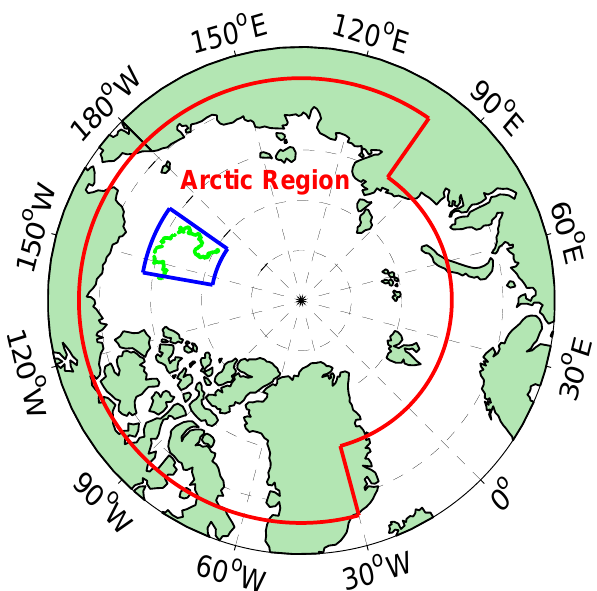
Fig. 1. Arctic Ocean as defined in this study. Ocean grid-points in the area enclosed by the red line are considered for the analysis. The green trajectory shows the drifting ice floe used for the SHEBA campaign and the area enclosed by the blue line is used for compar- ison with